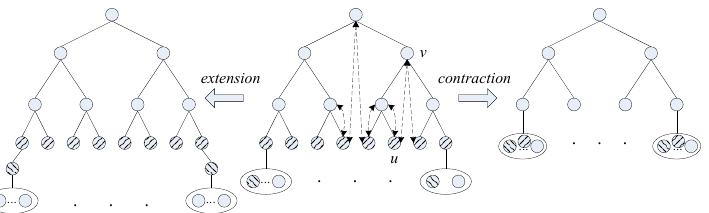
Figure 1. The initial D 3 -Tree structure ( middle ) and the operations of extension ( left ) and contraction ( right